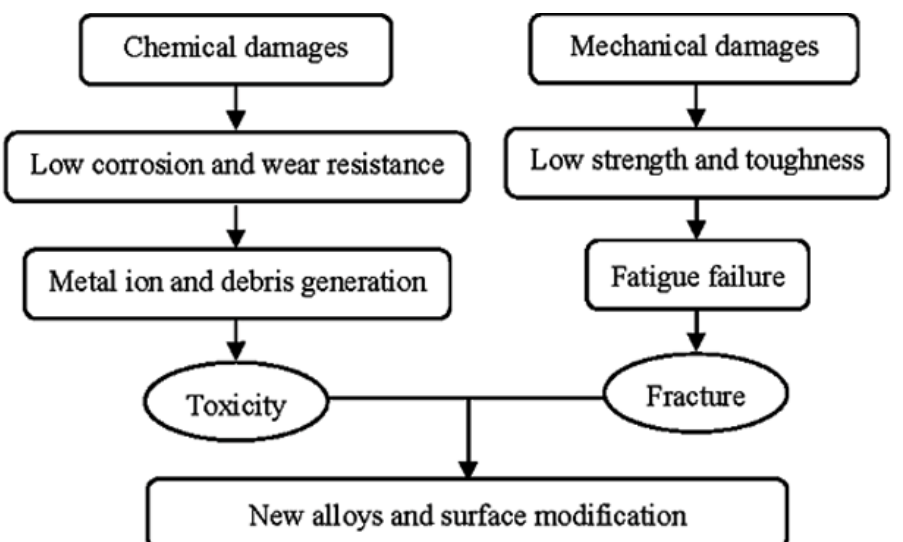
Figure 1. Degradation of metallic